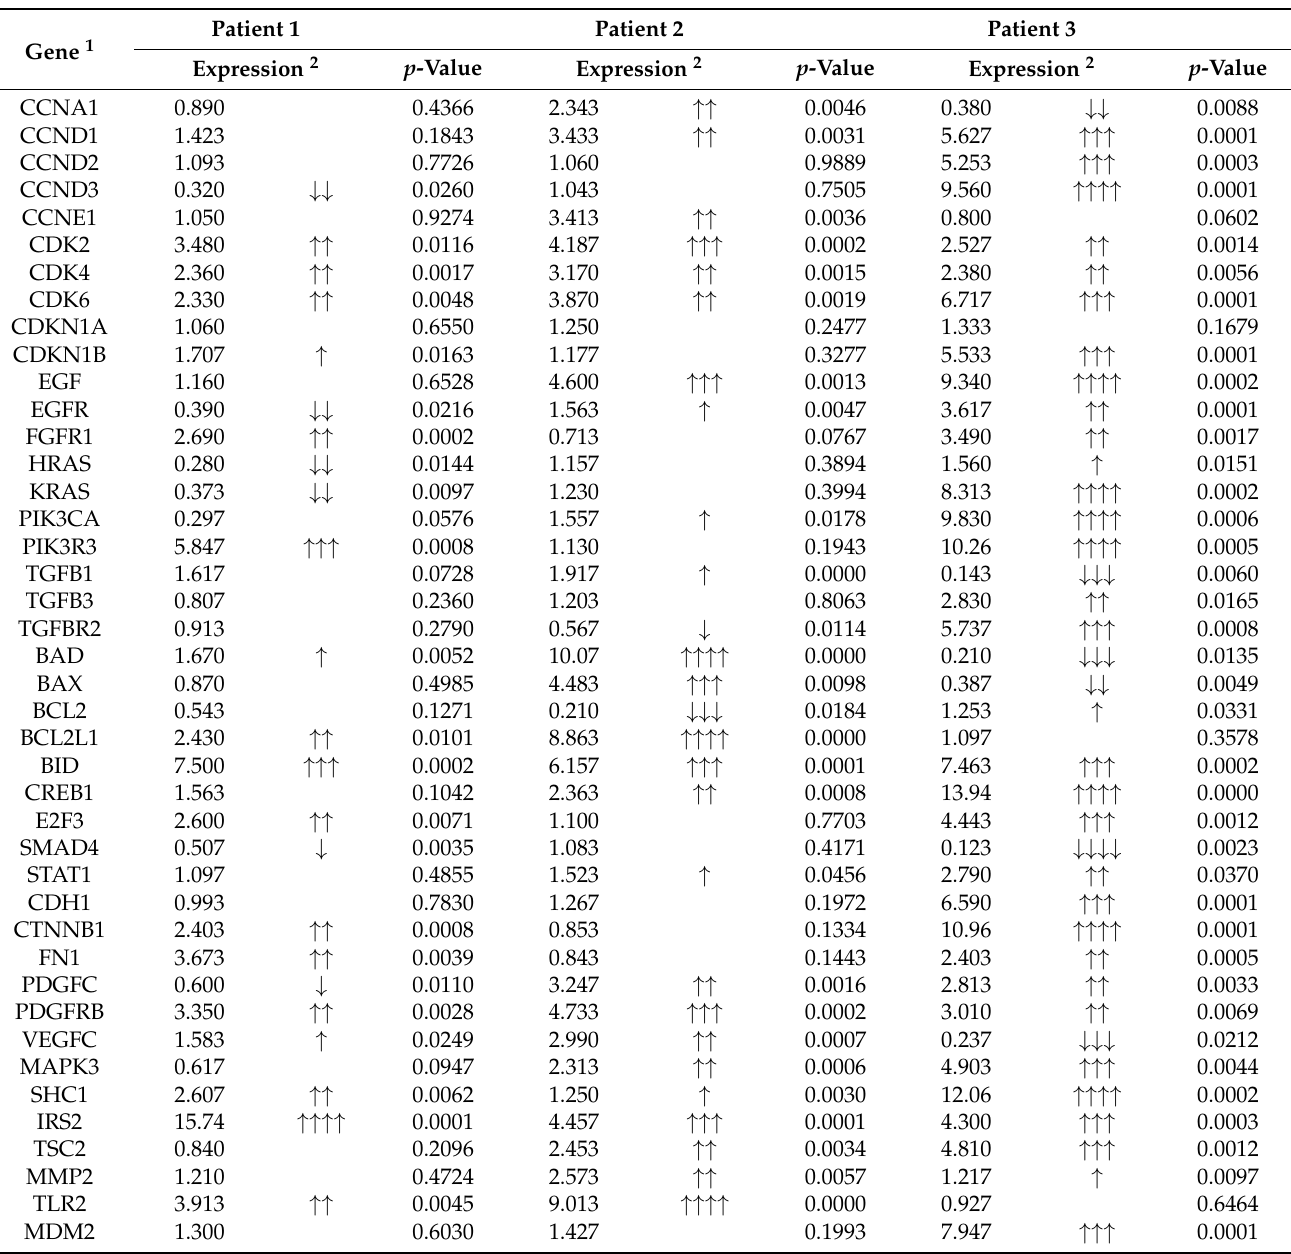
Table 3. Expression of the 42 selected mRNA tested in the excised CRC